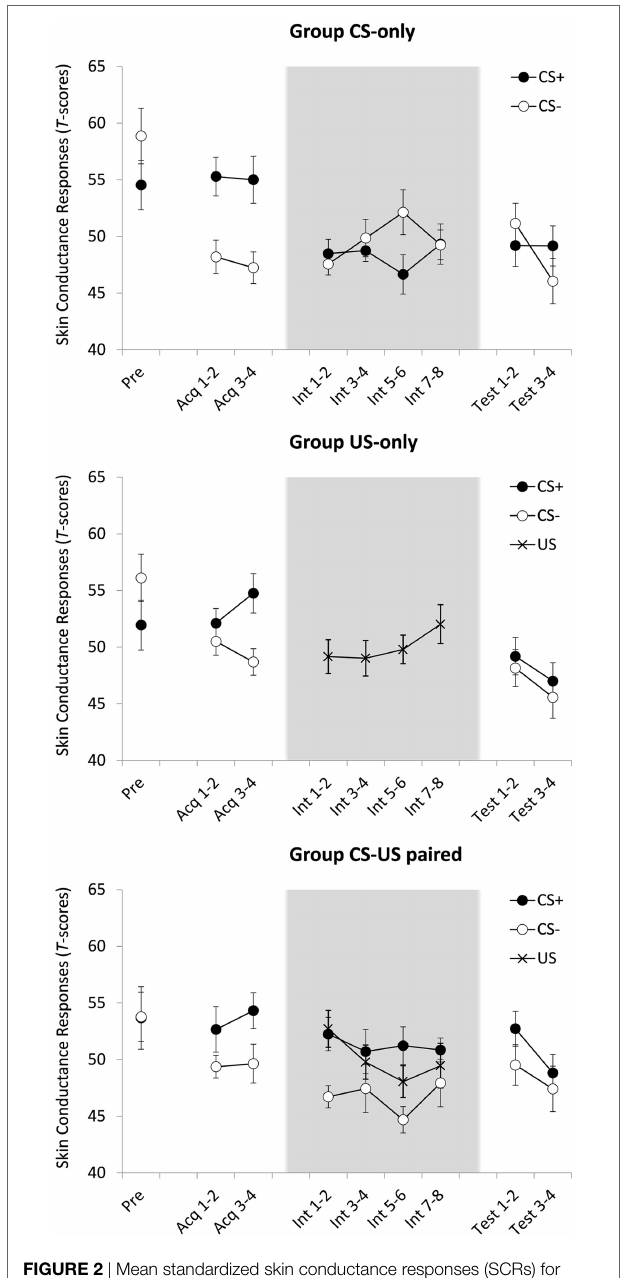
FIGURE 2 | Mean standardized skin conductance responses (SCRs) for groups CS-only, US-only, and CS-US-paired as a function of stimulus type (CS + /CS (cid:0) /US) and trial. Acq, acquisition trial; Int, intervention trial; Test, test trial. All groups received one CS-pre-exposure trial and four acquisition trials. Four test trials followed eight CS-alone presentations (group CS-only) eight US-alone presentations (group US-only) or eight continued CS–US pairings (group CS-US-paired). Background colors represent the experimental contexts. Error bars represent SEMs. Note that the data in this plot represent SCR magnitudes standardized across all test trials. These data were only used to test within-subject effects. When between-subject effects were tested acquisition and test data were T-transformed over all trials but the intervention trials (since the content of these trials was manipulated between groups). For groups US-only and CS-US-paired, the calculated magnitudes in response to US presentations during the intervention were T-transformed over all US amplitudes during